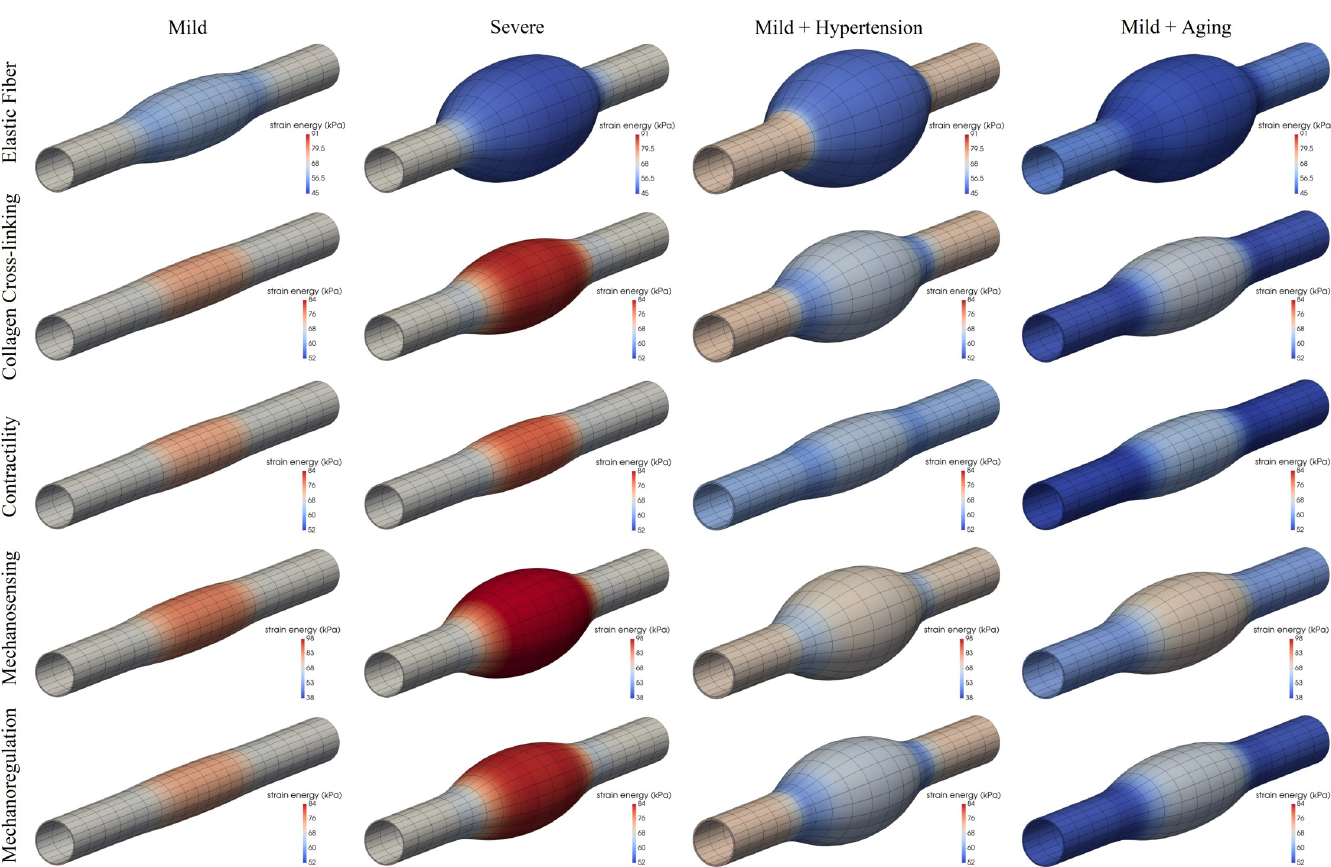
Fig 1. Fully developed, mechanobiologically equilibrated, axisymmetric dilatations of an initially cylindrical aortic segment caused by a mild (first column) or severe (second column) localized (via the respective parameter ϑ in Eq (9)) loss of elastic fiber integrity (first row, parameter c e , mild 32% and severe 62% reduction), central decrease in collagen cross-linking (second row, parameter c c , mild 9%, severe 23% reduction), loss of smooth muscle contractility (third row, parameter T max , mild 60%, 1 severe 100% reduction), compromised mechanosensing (fourth row, parameter δ , mild 7.5%, severe 18.5%, absolute), or compromised mechanoregulation (fifth row, parameter G c , mild 0.4%, severe 1.2%, relative change), with the risk factors of hypertension (third column, 50% increase in blood pressure) and aortic aging (fourth column, uniform 30% loss of elastic fiber integrity) superimposed on the mild insults. Shown are color maps for elastic energy storage per unit current volume for the mechanically-loaded geometries. Note that the original in vivo homeostatic value W = 68 kPa (light grey, centered mark). Both K a = K a j > 0 and η < 1 were o end t w s end adjusted via Eq (9) to maintain the distal and proximal segments normal (cf. Figs A and F in S1 Supporting